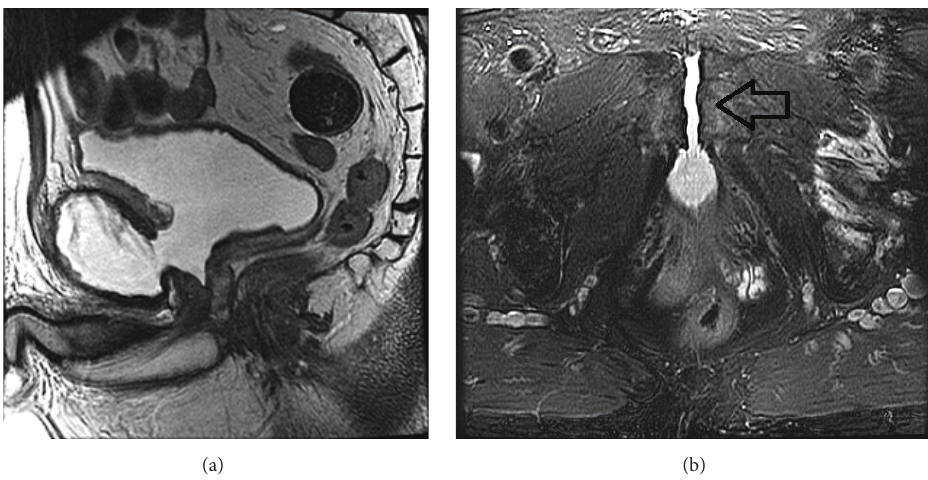
Figure 1: Images illustrate communication of anterior prostate and pubic symphysis. (a) is a midsagittal T2 weighted MRI without fat saturation. (b) is an axial T2 weighted MRI with fat saturation.